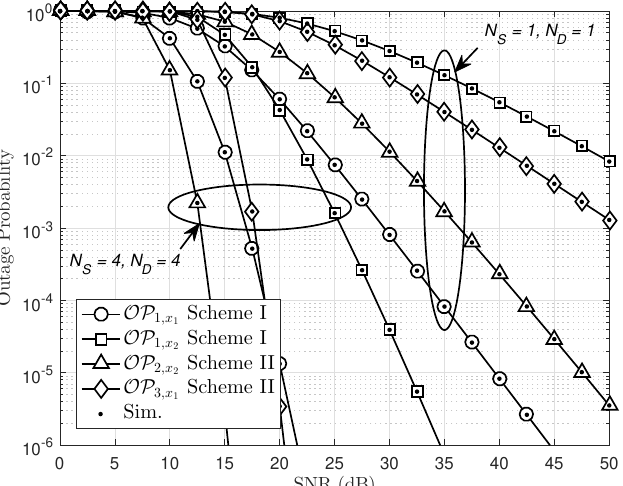
Figure 6. Comparison study on outage probability between Scheme I and Scheme II with d 1 = 2 m, d 2 = 3 m, a 1 = 0.2 and a 2 = 0.8.